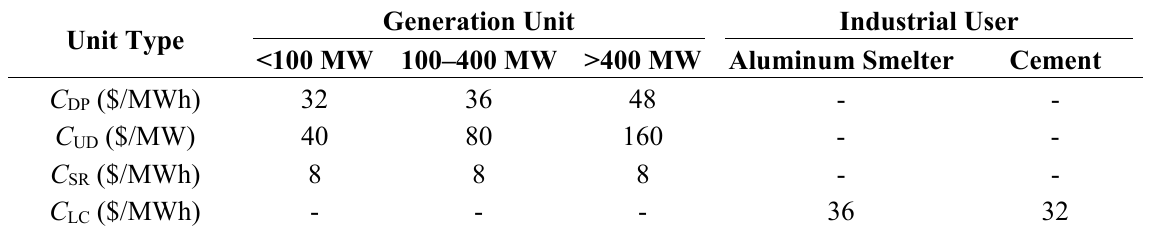
Table 6. The AS price of each type of suppliers.